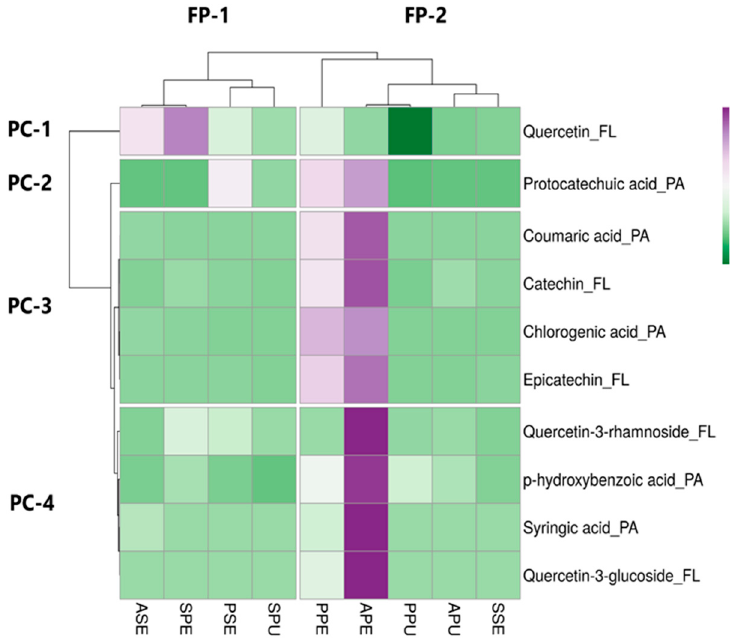
Figure 3. Heatmap displaying the distribution of phenolic compounds and the concentration among custard apple samples. Purple boxes represent the compounds with higher concentrations; green boxes represent the compounds with lower concentrations. African Pride peel, seed and pulp are abbreviated as APE, ASE and APU, respectively; Pink’s Mammoth peel, seed and pulp are abbreviated as PPE, ASE and PPU, respectively; soursop peel, seed and pulp are abbreviated as SPE, SSE and SPU, respectively; phenolic acids and flavonoids are abbreviated as PA and FL, respectively; phenolic compound clusters and fruit phenolic clusters are abbreviated as PC and FP, respectively.